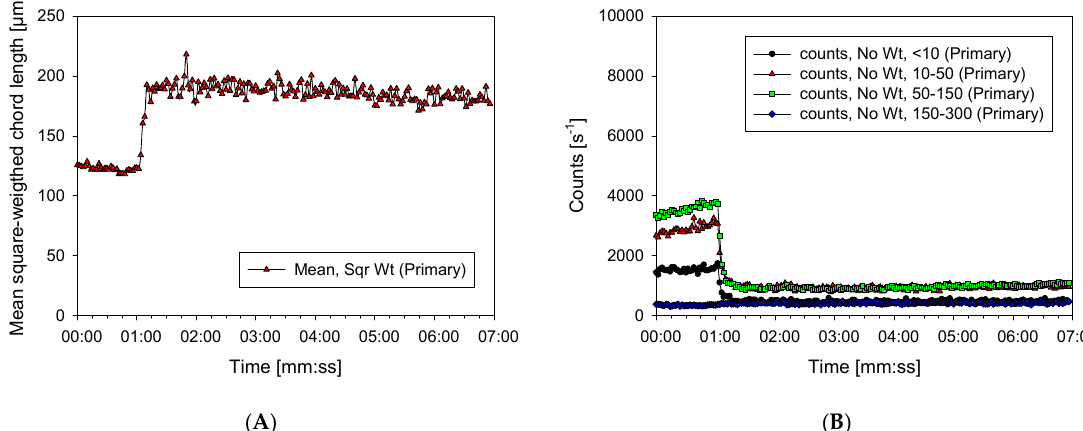
Figure 5. ( A ) Mean square chord length and ( B ) counts evolution of suspension; 5 ppm of guar gum added after 1 min (no frother or collector).